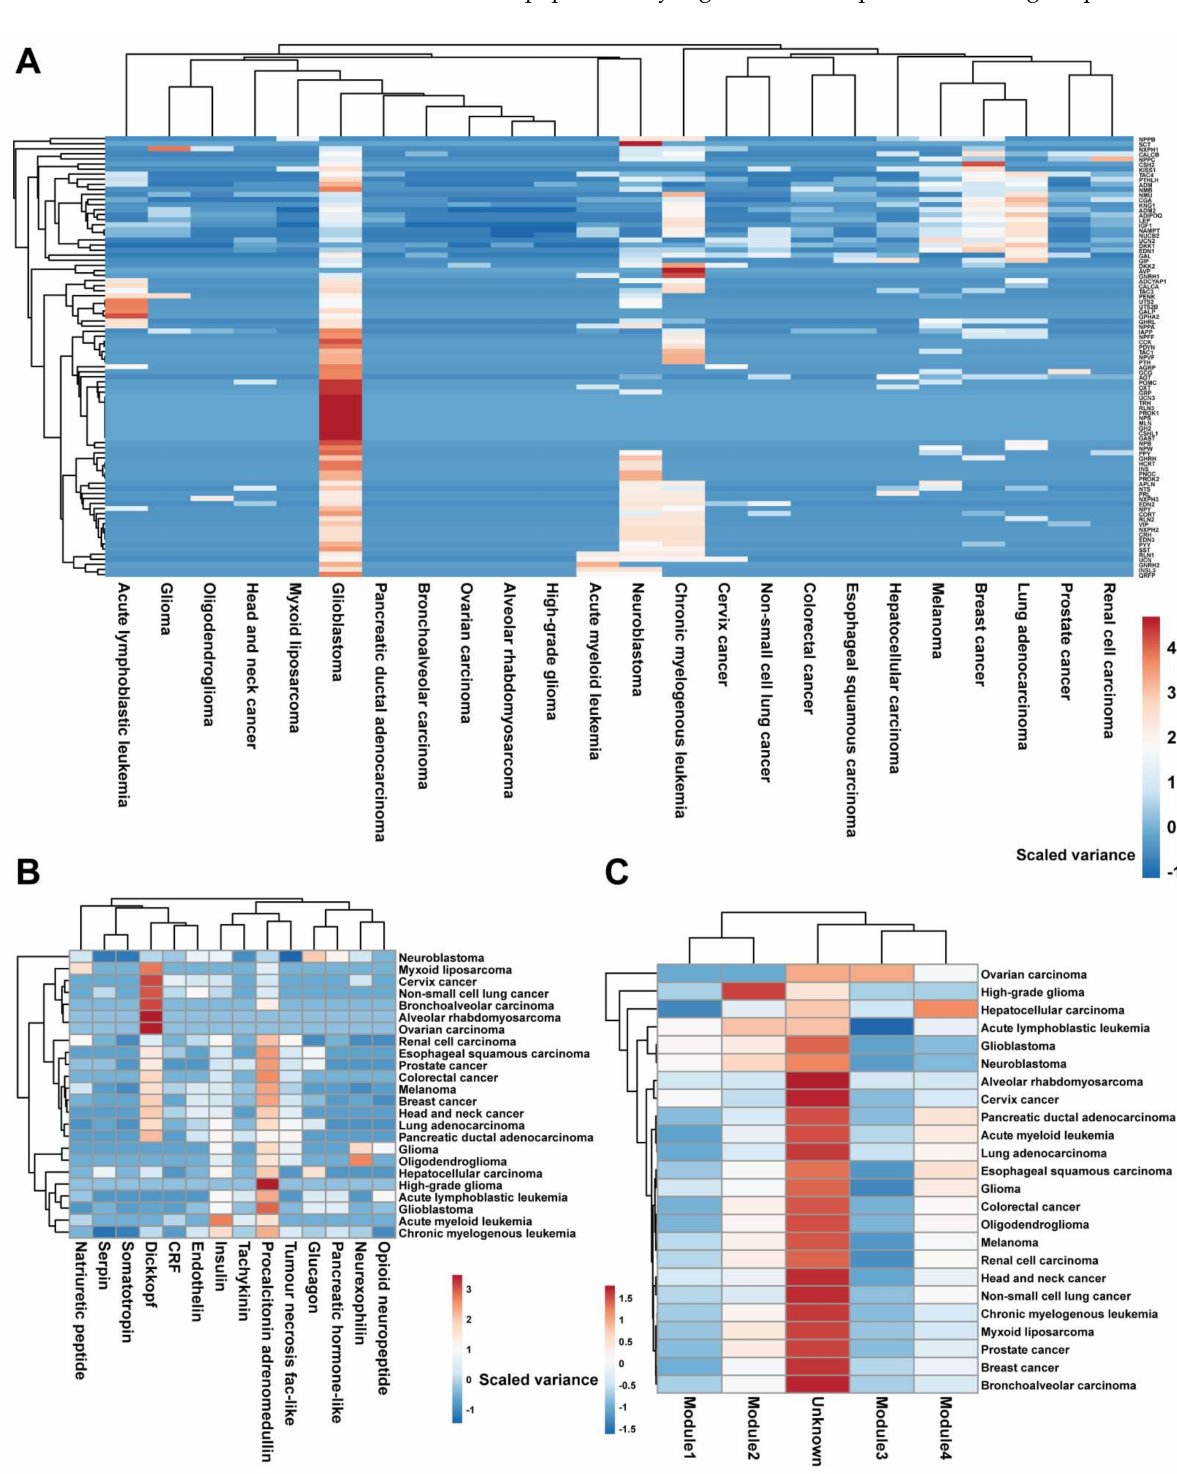
Figure 2. The overview of neuropeptide-receptor-based cell communication. ( A ) The heatmap depicts the number of cell-to-cell communications initiated by 89 neuropeptides (rows) in 24 cancer types (columns). ( B ) The heatmap depicts the total cell-to-cell communications initiated by 14 neuropeptide families (columns) among 24 cancer types (rows). ( C ) Across 24 cancer types, the heatmap shows the cell connections initiated by four neuropeptide-receptor functional modules (columns)